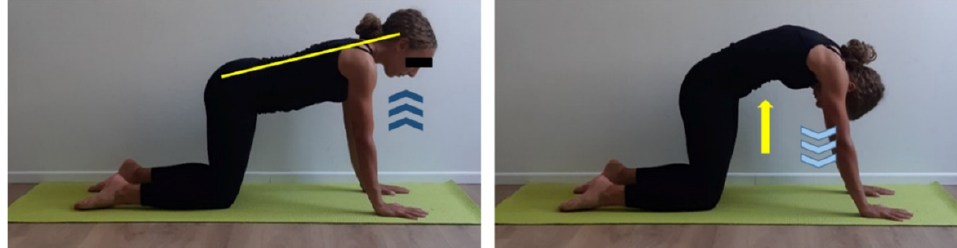
Figure 4. Spine mobilization exercise in quadruped position. Quadruped position, neutral spine attitude (yellow line), set hands shoulder-width apart and knees and feet hip-width apart. Inhale (dark blue arrows) then exhale (light blue arrows) and perform a posterior pelvic tilt and a head flexion (yellow arrow), inhale, and get back to start position paying attention not performing an anterior pelvic tilt. Two sets of 10 repetitions, 30 s recovery.